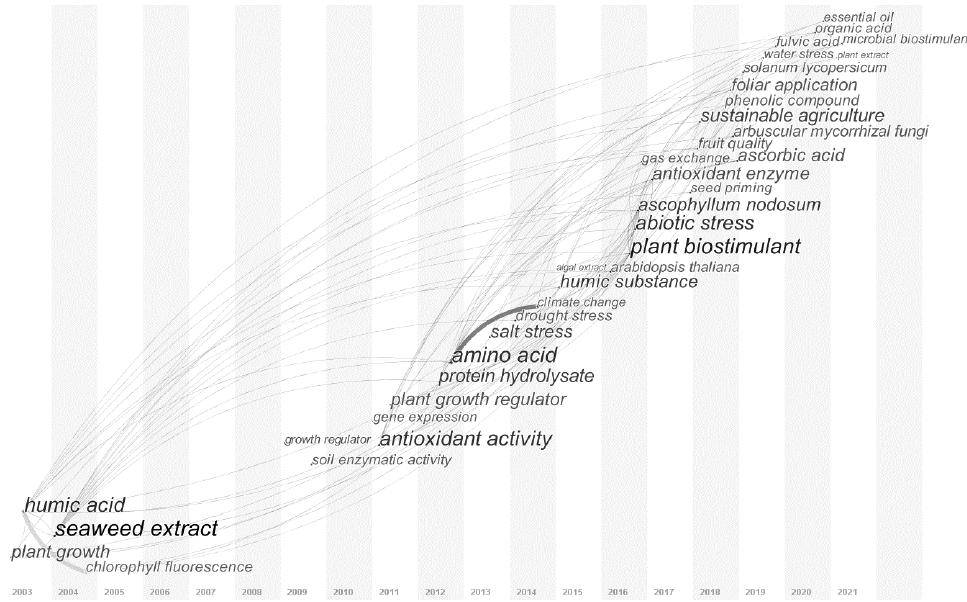
Figure 3. Time zone view of WoS biostimulant hotspots keywords from 2000 to 2022; the size of the keywords is proportional to their frequency.